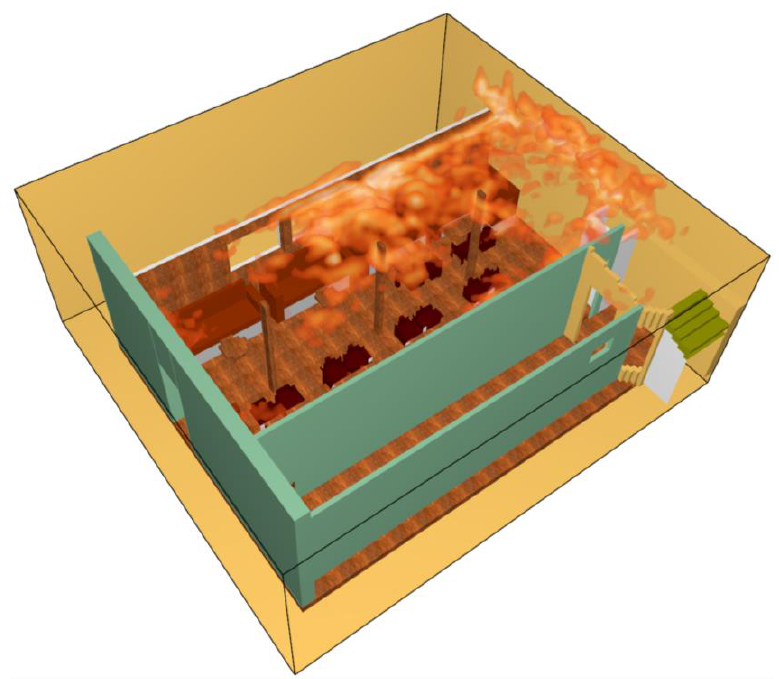
Figure 9. Combustion of furniture by thermal radiation and hot gases.